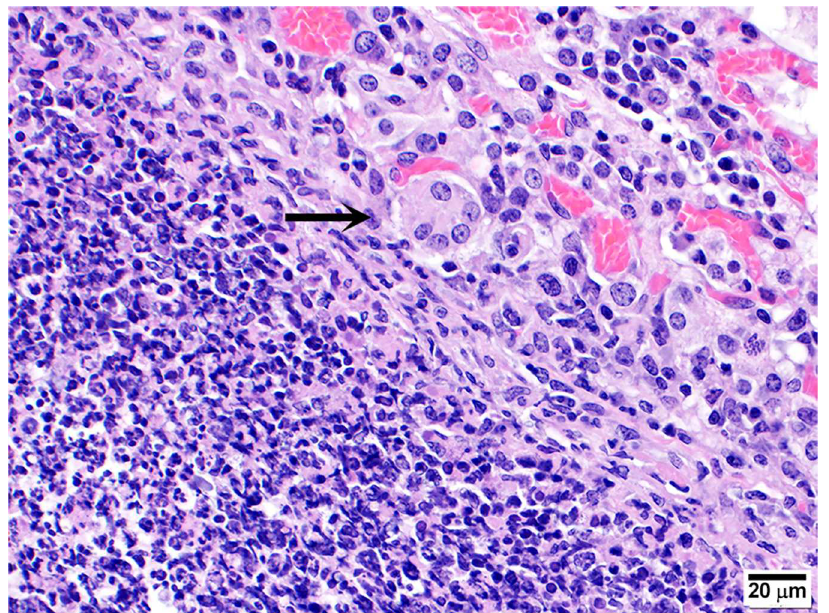
Fig 15. Representative micrograph demonstrating the presenceof MNGC in mice exposed to aerosolized bacteria. MNGC (arrow) observed in the lungs of a BALB/c mouse exposedto approximately 5 CFU of aerosolized B . pseudomallei K96243 and was euthanizedafter meetingearly end-pointeuthanasia criteria 20 days